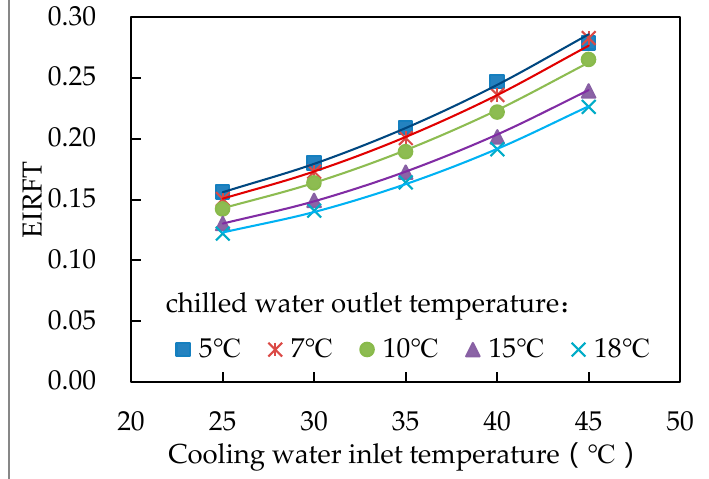
Figure 6. Changes in cooling capacity and cooling water inlet temperature.